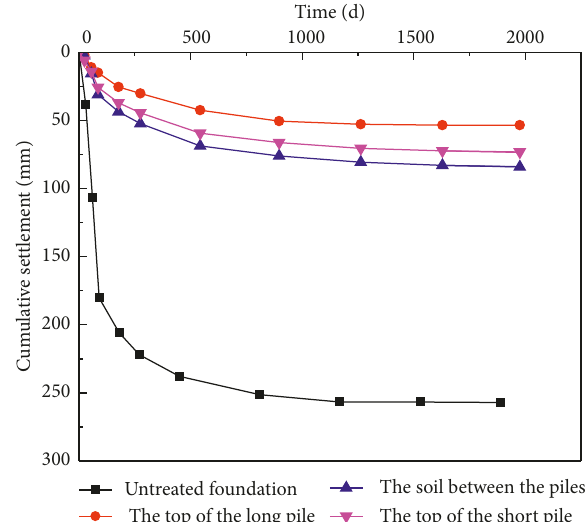
Figure 7: Cumulative settlement curves of untreated foundation and long-short pile composite